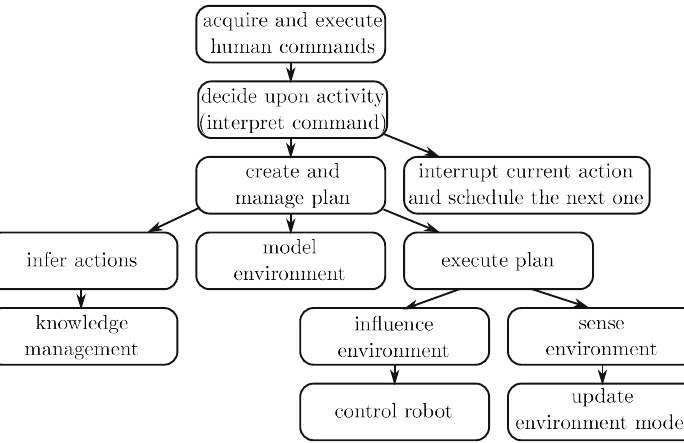
Figure 5. Requirement hierarchy for the Robot Companion.